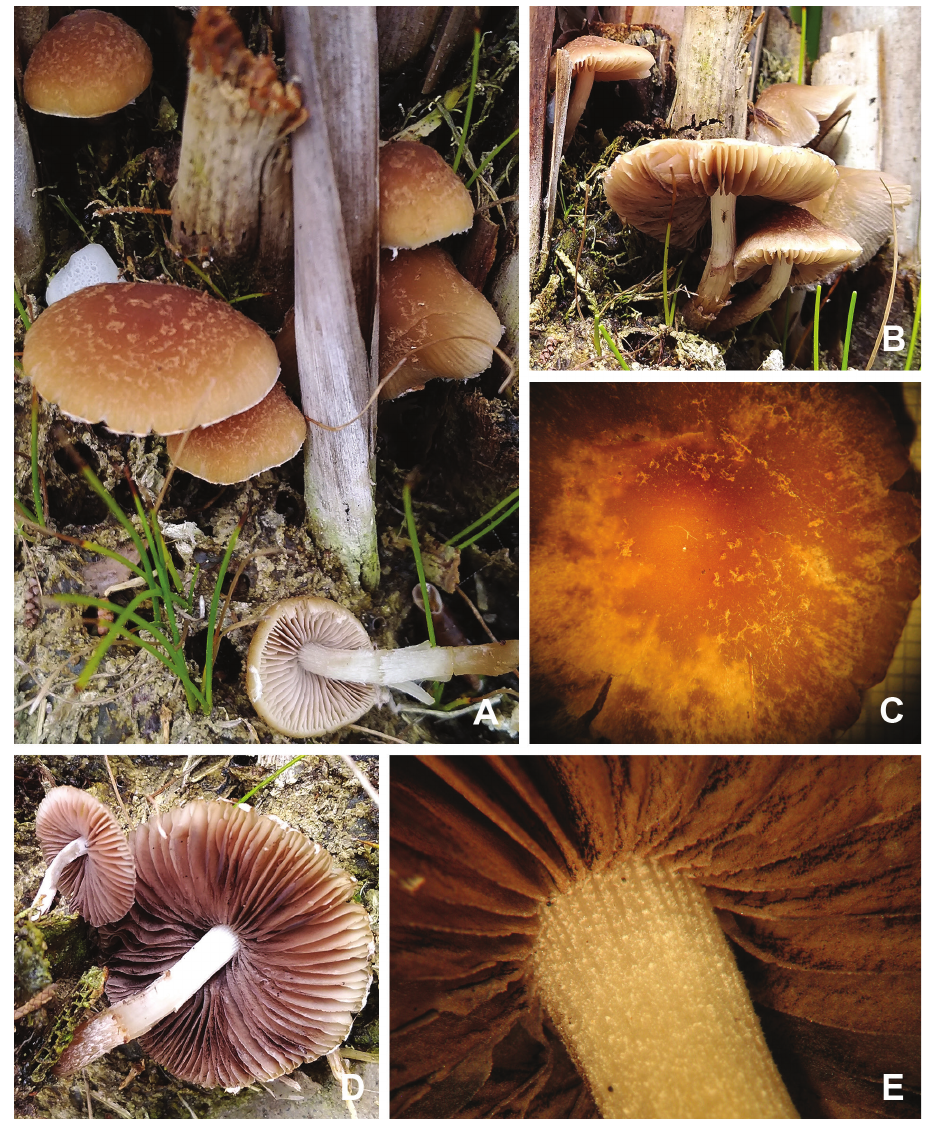
Figure 2. Macro-morphological characteristics of the Psathyrella basidiomes: scales of velar origin on pilei tops and margins, and beige-coloured gills ( A ); cylindrical, white and exannulate stems under a lateral profile ( B ); colour-shading of a cap hygrophany and fibrillose details of velar-originated scales ( C ); gills turning brown-purplish with spore maturation and a fibrillose surface of a stem base ( D ); a pruinose stem apex bearing a mature hymenophore with white gill edge lines ( E